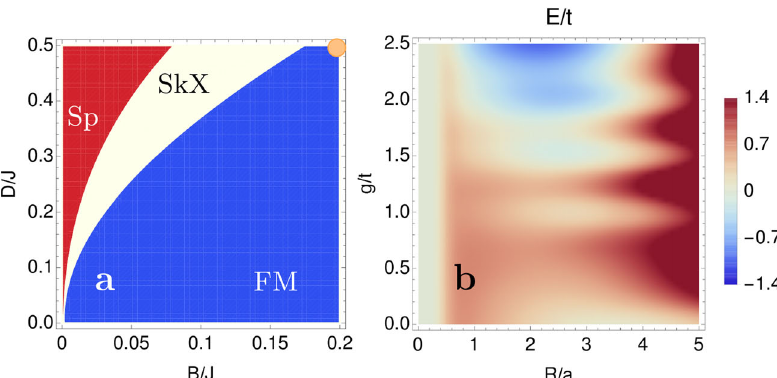
Fig. 2 Equilibrium magnetic properties. a Magnetic phase diagram of the isolated d -electron spin system ( g = 0) as a function of external magnetic fi eld B and Dzyaloshinskii – Moriya interaction (DMI) D . Blue areas indicate a ferromagnetic (FM) state, red areas a spiral (Sp) state and white areas a skyrmion crystal (SkX) state. b Excitation energy E = E Sk − E FM of a single skyrmion as a function of skyrmion radius R and s – d exchange g , for the parameters J = 50, D = 25, and B = 10 meV, t s = 1 and α s = 0.5 eV. The orange dot in ( a ) indicates the values of the d -electron spin parameters used in ( b ).